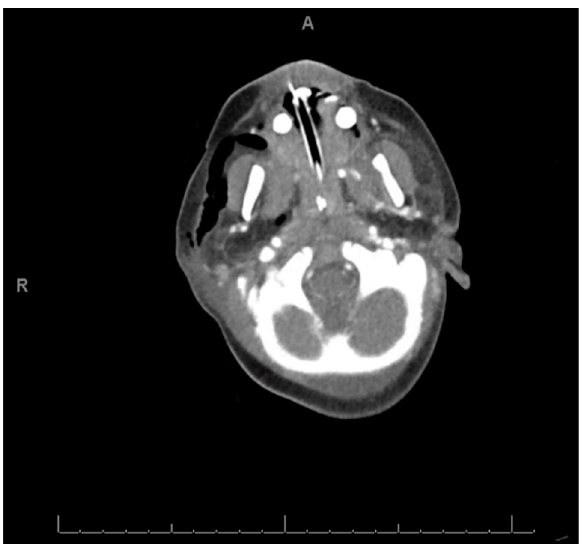
Figure A1. Computed tomography scan of our patient taken two days after the adenotonsillectomy. The image shows infiltrative soft-tissue and subfascial emphysema in the facial region particularly on the right side.